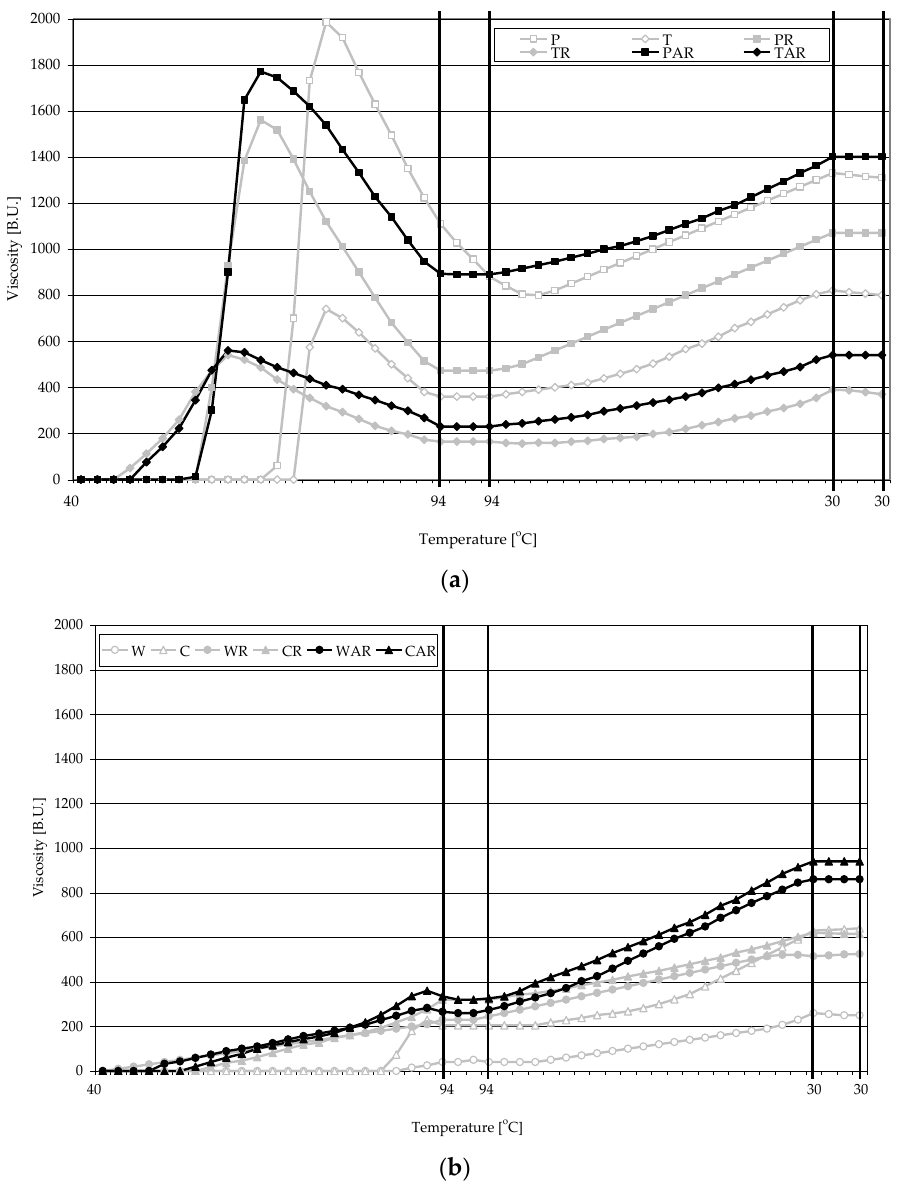
Figure 4. Brabender pasting characteristics of native (N), retrograded ® , and acetylated retrograded (AR) starch from: ( a ) — potato and tapioca, ( b ) — wheat and corn.